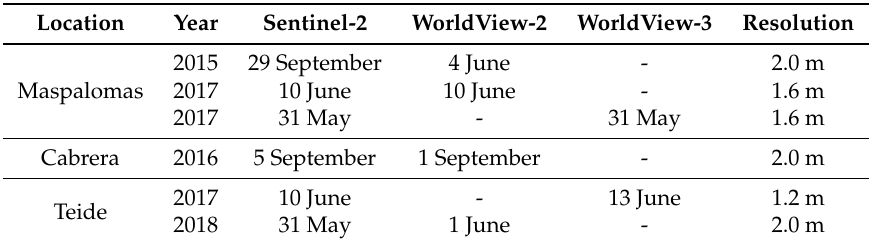
Table 2. W-S Set1: WorldView and Sentinel-2 pairs.